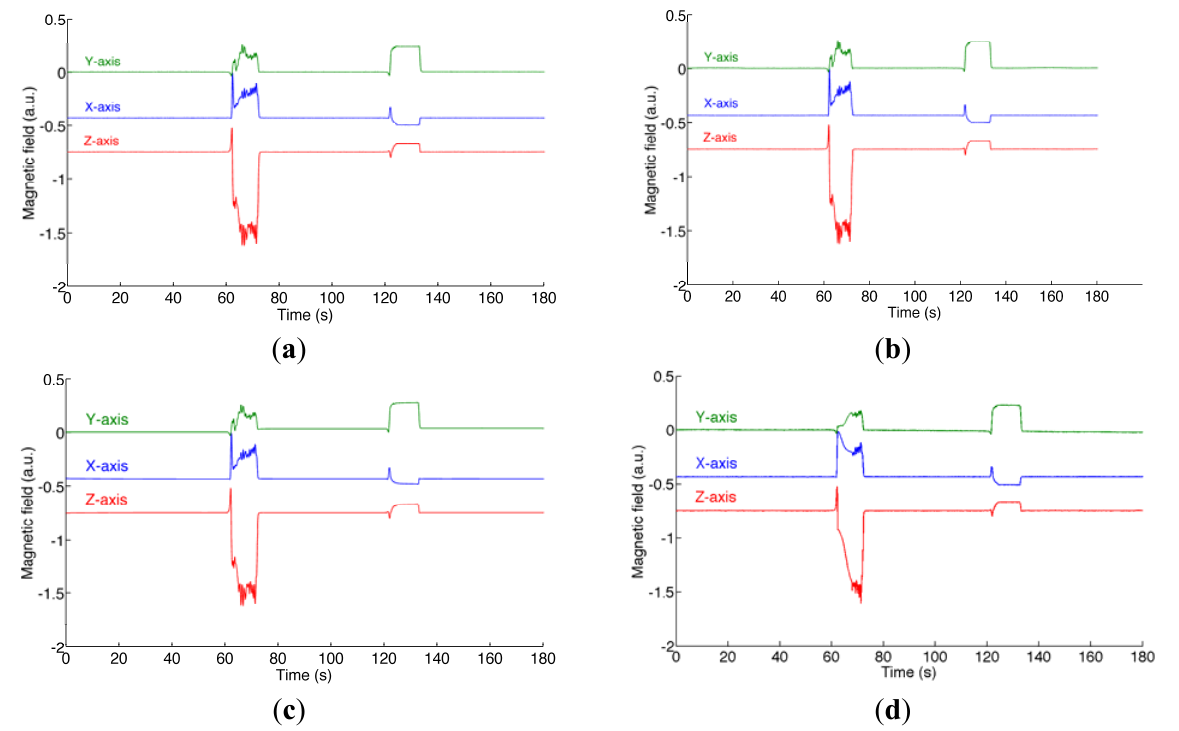
Figure 1. Static test. ( a ) The ground-truth magnetic field; ( b ) The magnetic field estimated by the VSD-EKF; ( c ) the magnetic field estimated by the higher-order EKF; ( d ) the magnetic field estimated by the quiescent